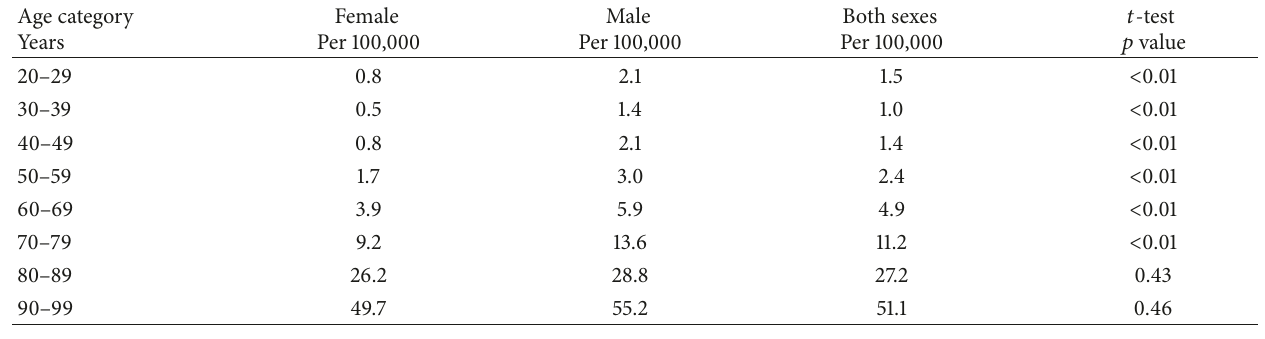
Table 2: Incidence of C2 fractures per 100,000 within age subgroups according to gender (presented with 𝑝 values of 𝑡 -test for gender difference).